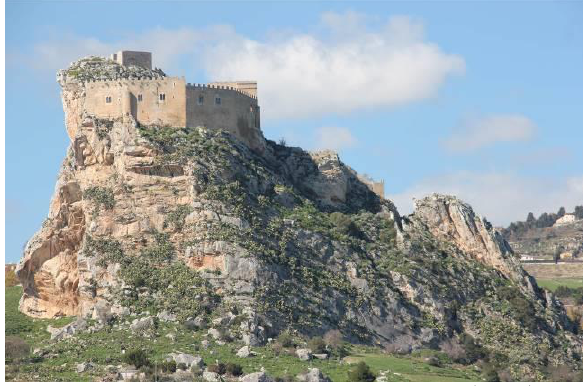
Figure 1. The Medieval Castle of Mussomeli (Sicily)